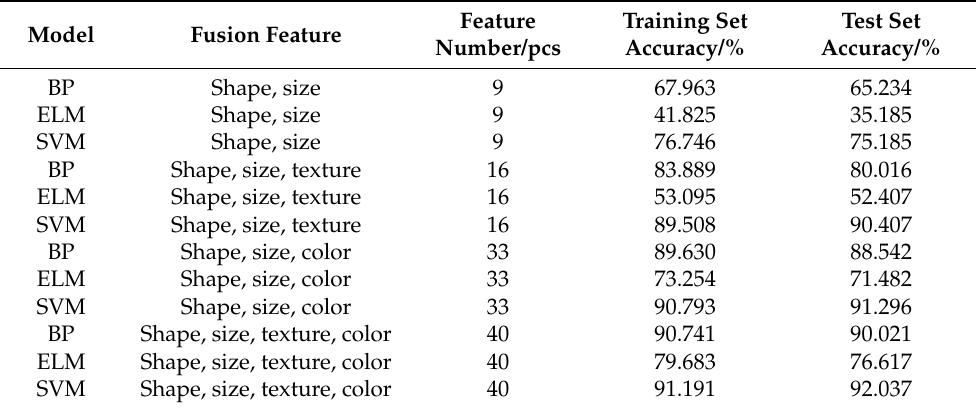
Table 2. Comparison of classification models based on different fusion